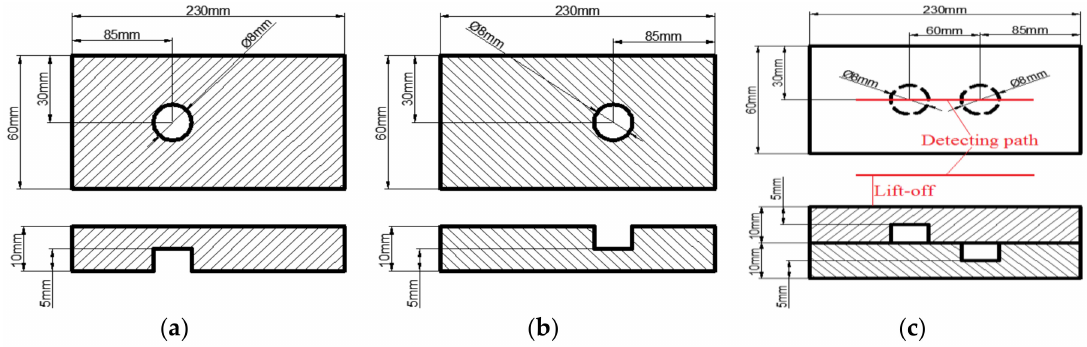
Figure 12. Schematic diagram of insulator layer and conducting specimen: ( a ) insulator layer, ( b ) conducting specimen, ( c ) conducting specimen covered by insulator layer.